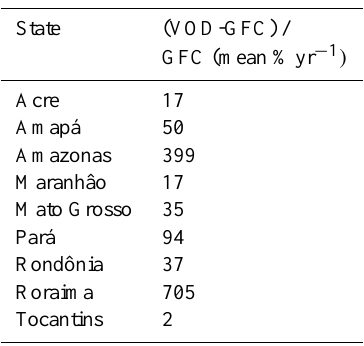
Table 4. Average error for the Brazilian states. The error is defined as the VOD minus GFC forest loss area expressed as a percentage of GFC forest loss for the overlapping time period per state in the Legal